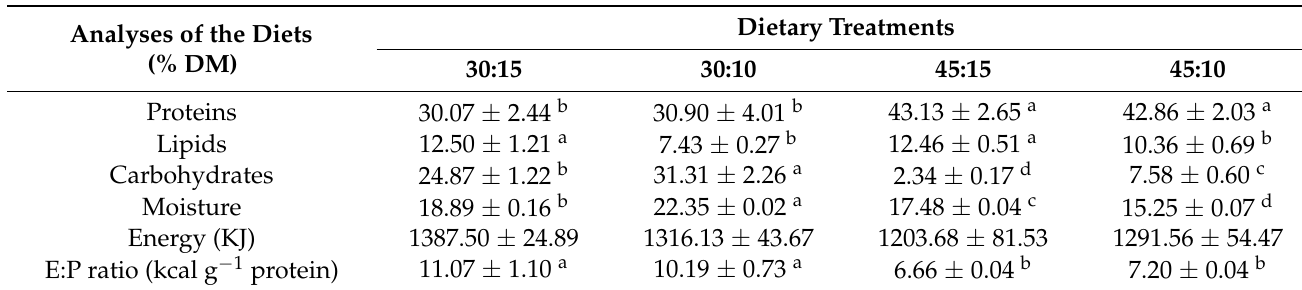
Table 3. Composition of the experimental diets after manufacture. Data are expressed as mean ± S.D. ( n = 3). Different superscript letters denote the presence of differences statistically significant between dietary treatments (one-way ANOVA, p < 0.05). Dietary treatment codes correspond to the protein:lipid level included in tested diets. DM, dry matter.